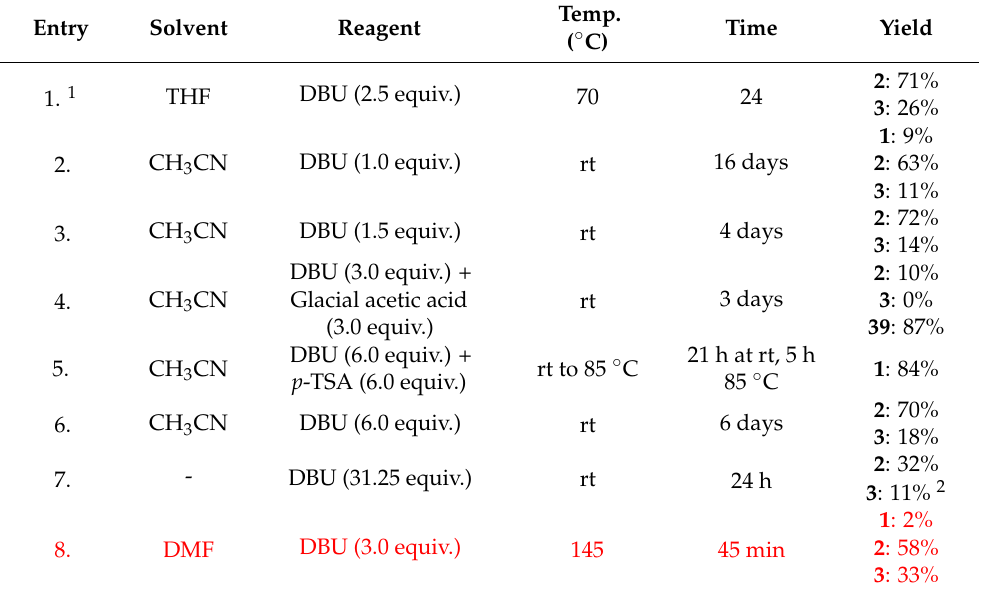
Table 1. Optimization trials to improve the yield of the DBU-conjugated derivatives.